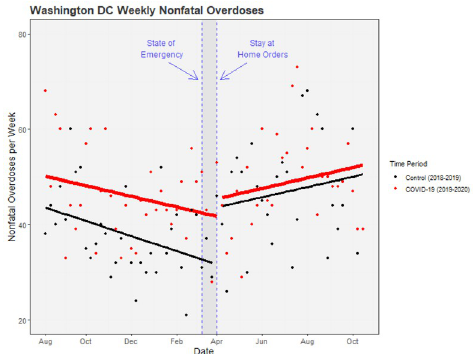
Fig 3. ITS adjusted weekly nonfatal overdose counts in Washington DC pre- and post-Covid-19 public health orders. Points represent weekly counts of suspected nonfatal overdoses. Solid lines represent ITS-model-predicted counts: red for the Covid-19 time series (including March 2020), black for the preceding time series (including March 2019). Washington DC models are adjusted for seasonality with quarter-year dummy variables. Quarter-year dummies are set to their means to generate a smooth line. Dashed horizontal lines mark the official declaration of a state of emergency (March 11th, 2020) and stay-at-home orders (March 30th, 2020) in Washington DC.